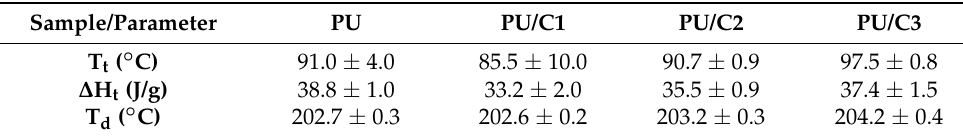
Table 6. Summary of DSC analysis results.